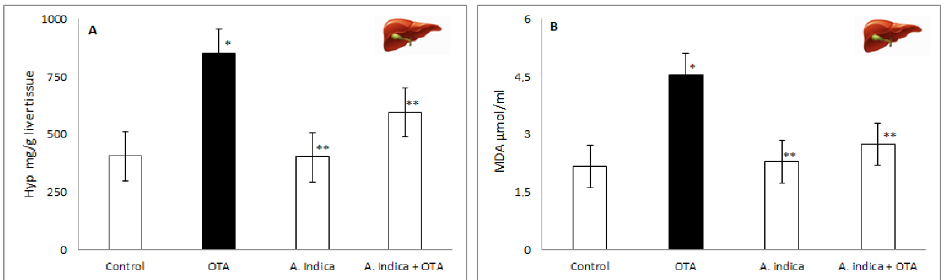
Figure 4. ( A ) The A. indica oil effects on OTA-induced oxidative changes in liver hydroxyproline content and ( B )—lipid peroxidation measured as MDA (µmol/mL). The results are presented as mean ± SEM. The significant difference used in relation to controls (*) p < 0.05 vs. controls, (**) p < 0.05 vs. OTA treated mice.